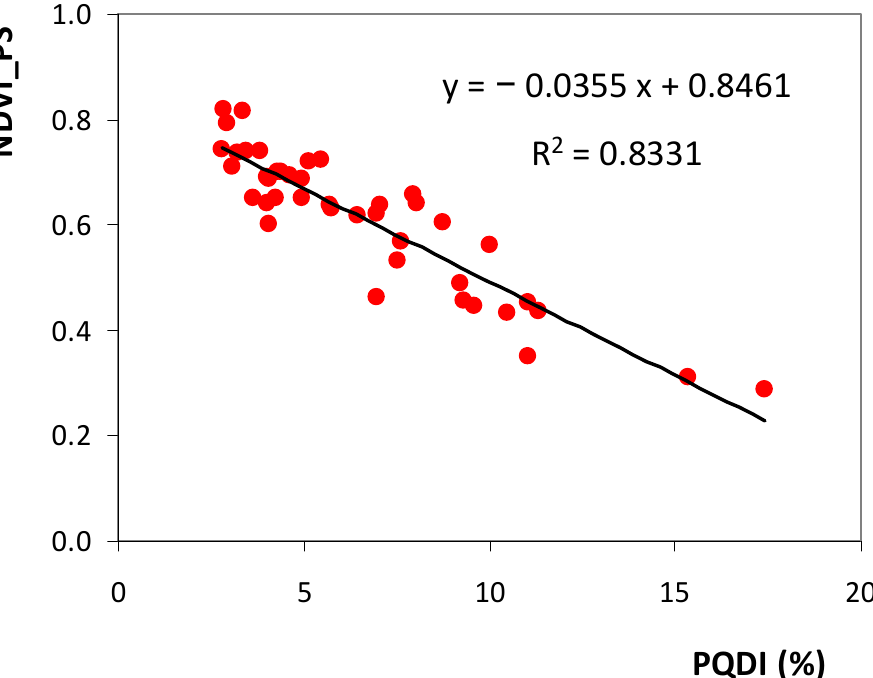
Figure 20. Regression analysis between NDVI obtained by proximal sensing (NDVI PS ) and Pasture Quality Degradation Index (PQDI).